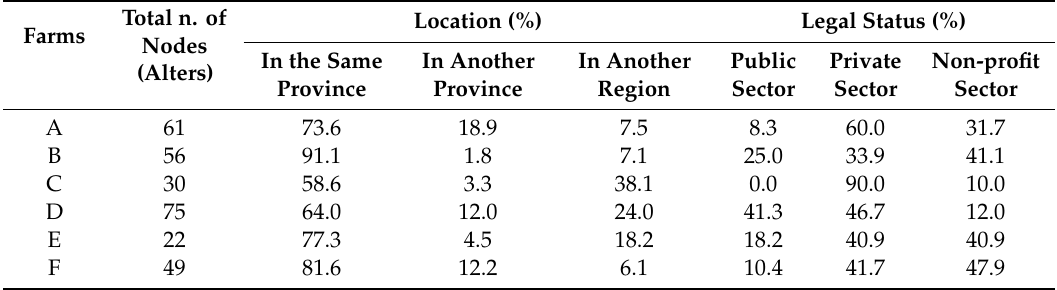
Table 2. Number, location and legal status of the nodes (time point: T0)